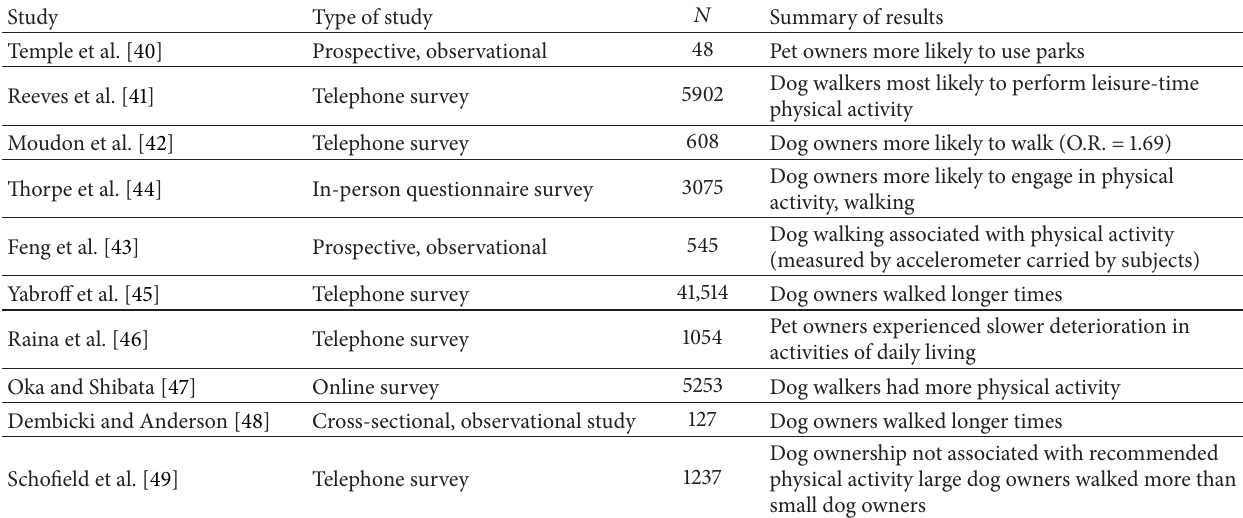
Table 3: Studies on the use of animals on physical